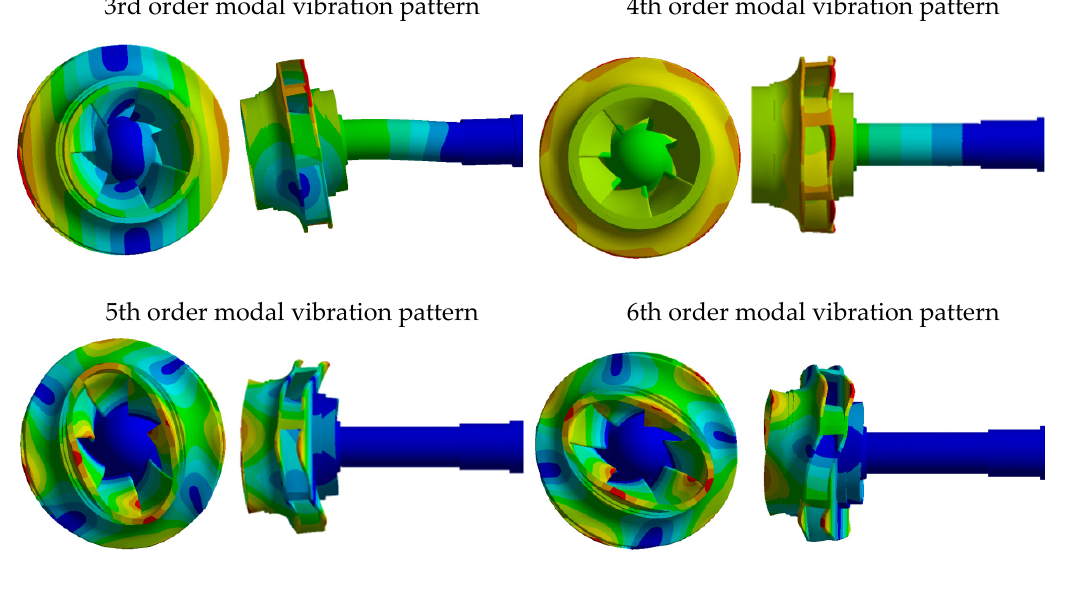
Figure 14. Fore eight modes of case A.